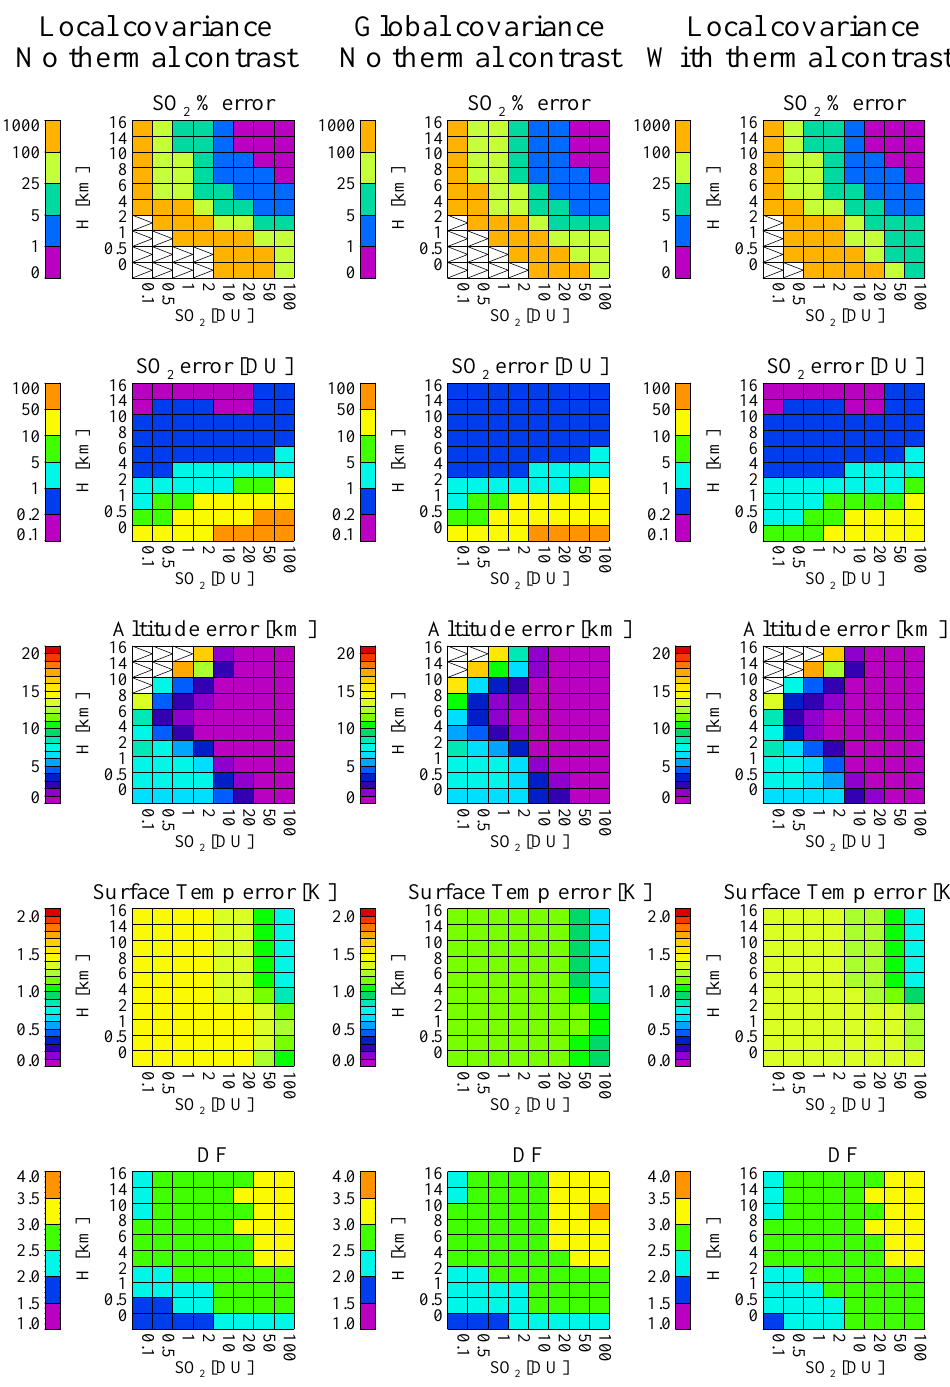
Fig. 3. The error in the retrieved state and the degrees-of-freedom in the retrieval are shown as a function of SO 2 column amount (on the ordinate) and the altitude of the plume (on the abscissa). From top to bottom the rows show the percentage error in SO 2 column amount, the absolute errors in the SO 2 column amount, plume altitude, and surface temperature and the last row shows the degree-of-freedom in the retrieval. The columns denote the values obtained using (i) the local error covariance matrix for April and no thermal contrast between surface and atmosphere, (ii) the global error covariance matrix and no thermal contrast, and (iii) the local covariance matrix and 10K of thermal contrast between surface and atmosphere. Values higher than the colour bar are shown by a white box containing the symbol “ >